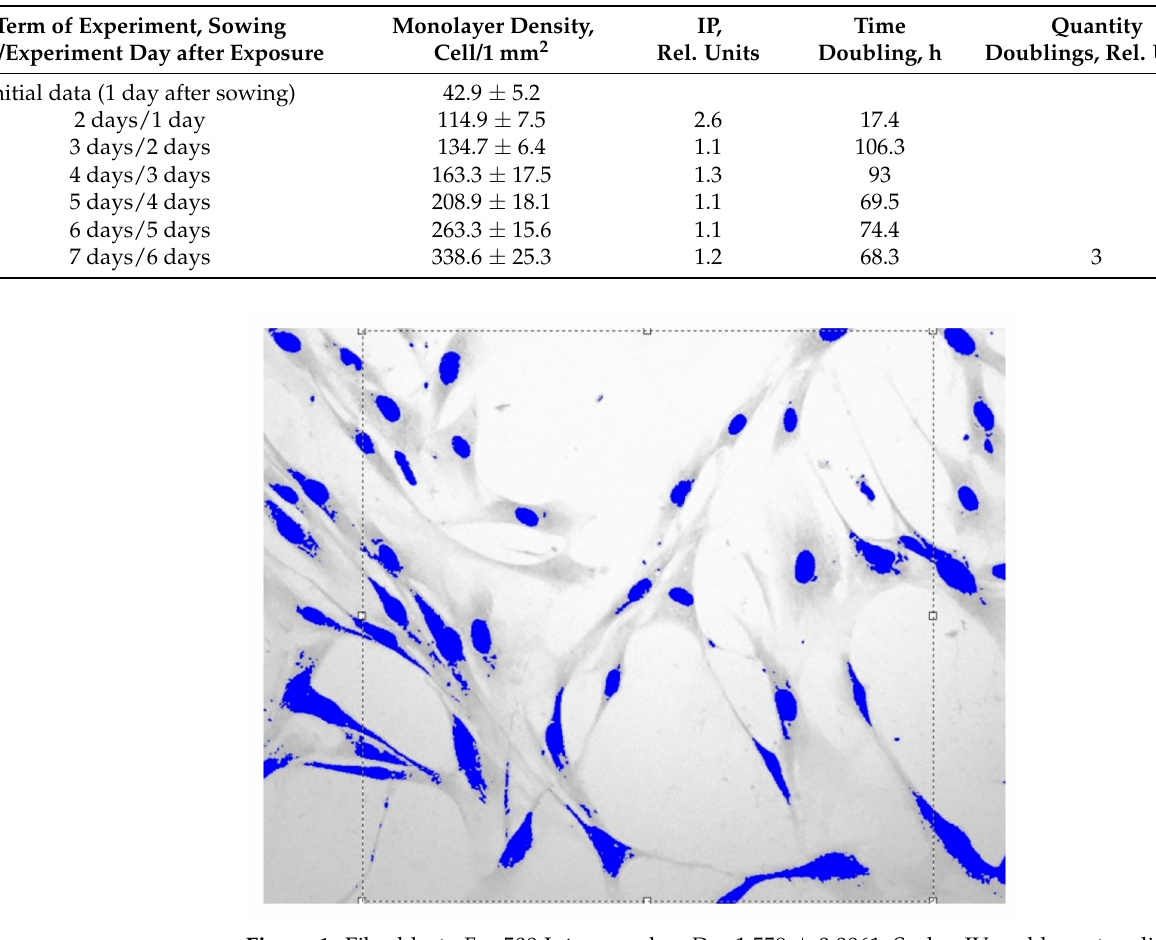
Figure 1. Fibroblasts E = 500 J, t = one day, D = 1.559 ± 0.0061, Sudan IV and hematoxylin-eosin staining, magnification n = 200.